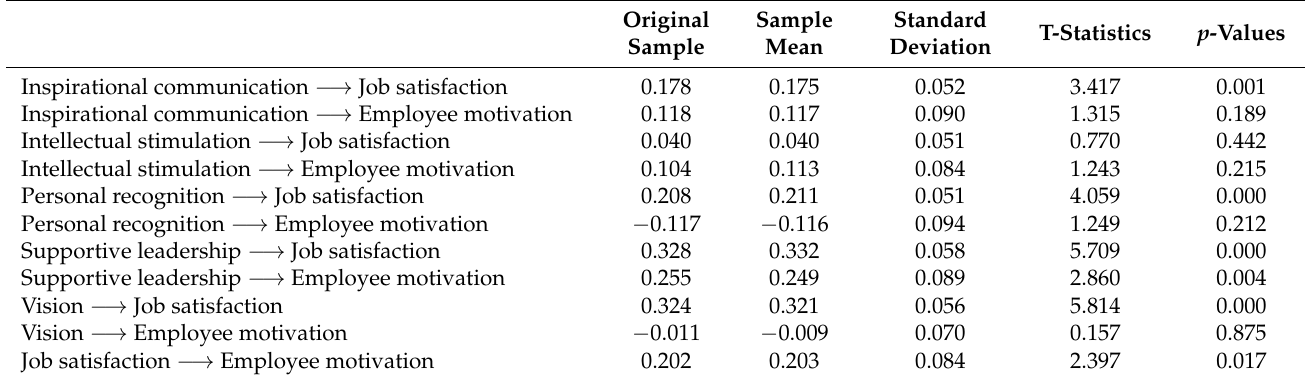
Table 8. The model